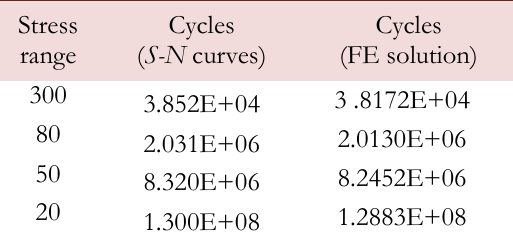
Table 5: Comparison of S-N curve data and numerical results for 2.873 mm initial crack